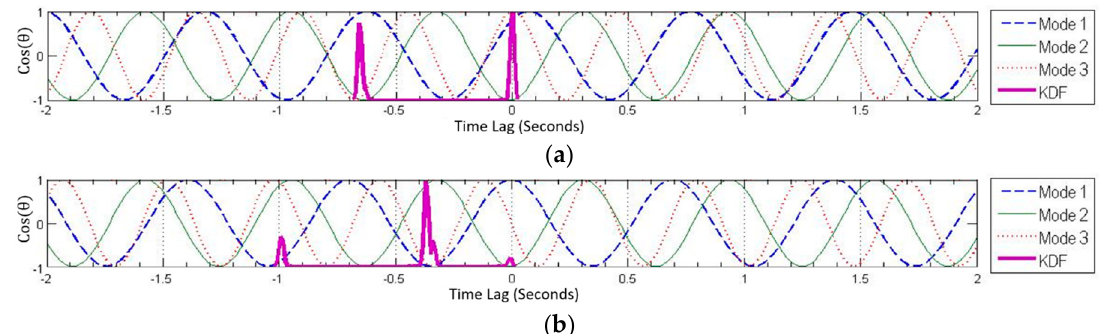
Figure 10. PATL superposition with KDF for node #4 in synchronized ( above ) and unsynchronized ( below ) datasets. Due to low levels of noise, the resulting KDF has only one peak at the correct solution for both datasets.